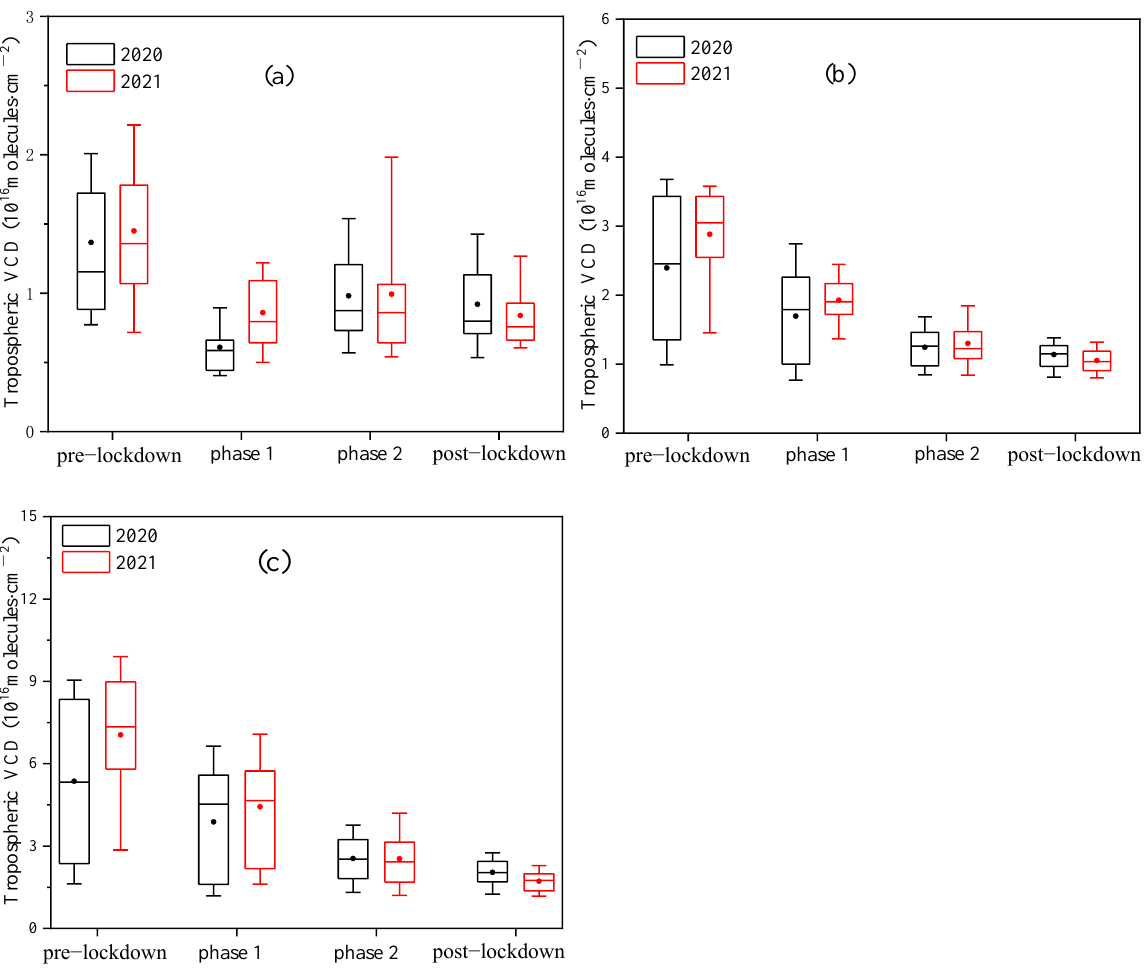
Figure 4. Box diagram of ( a ) NO 2 , ( b ) HCHO and ( c ) SO 2 VCD obtained by the MAX-DOAS instrument during observation. The low (upper) error bars and boxes are the 10th (90th) and 25th (75th) percentiles of the data grouped in each interval, respectively.